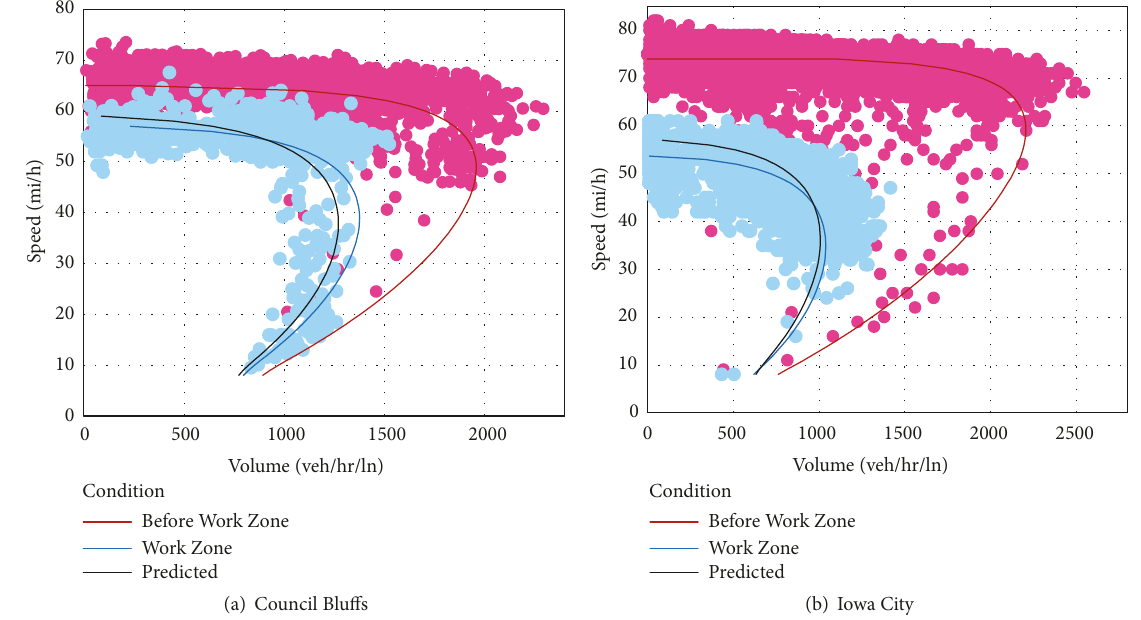
Figure 4: Speed-volume relationships before and during work zone.